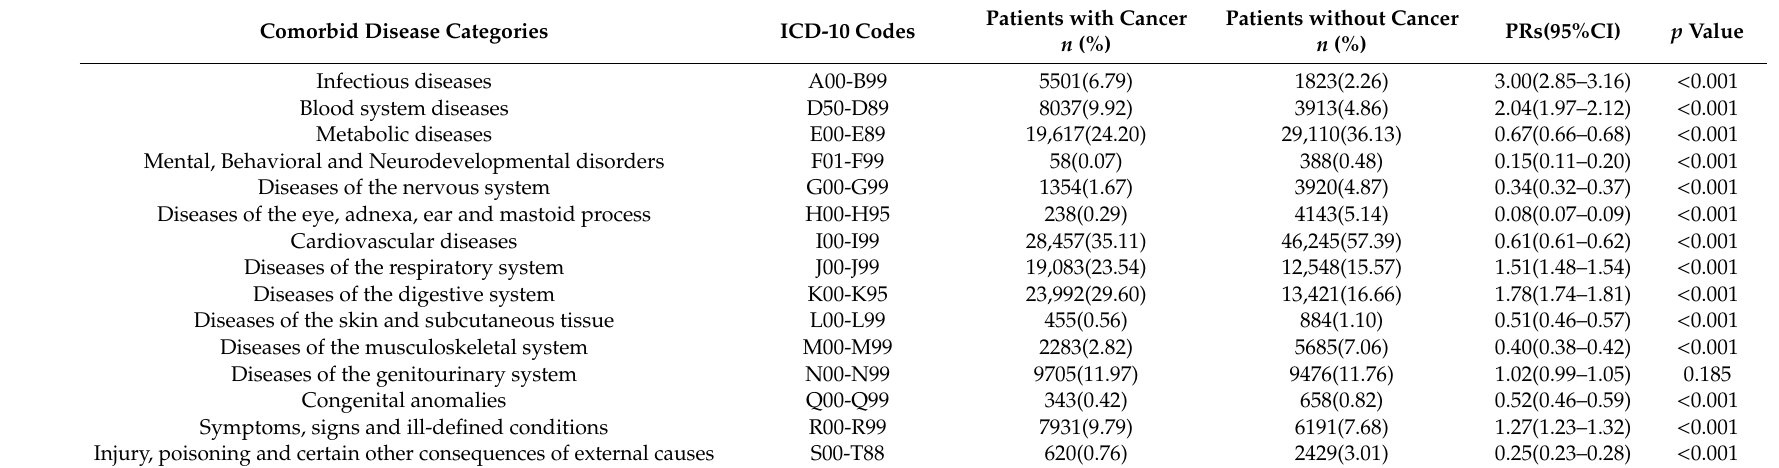
Table 2. Comorbidity prevalence and prevalence ratios in elderly patients with and without